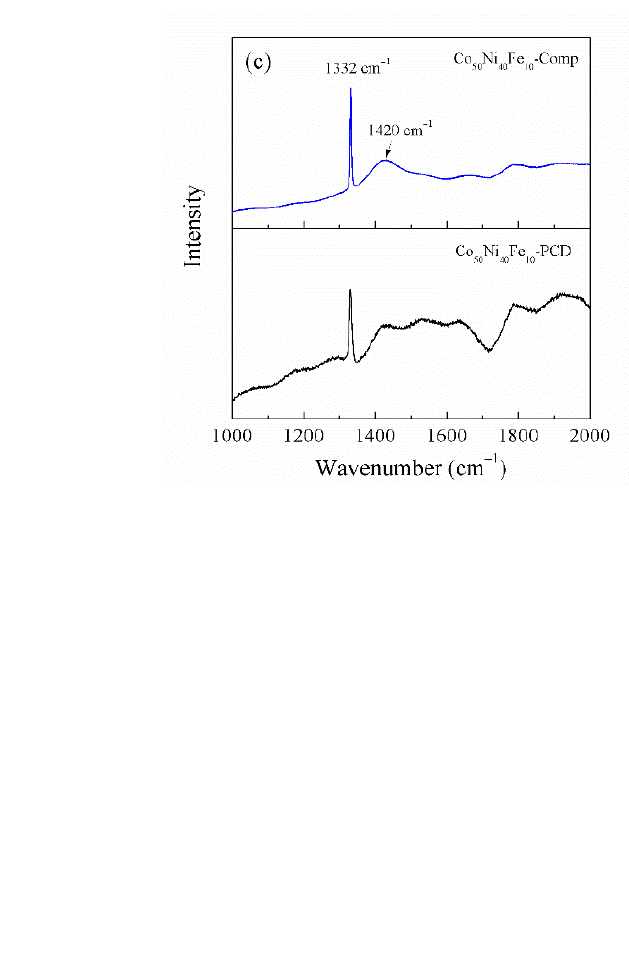
Figure 5. Phase analyses of diamond composites and PCD: ( a ) XRD patterns; ( b ) multi-peaks fitting around 44 ◦ in ( a ); ( c ) Raman spectrum of diamond.